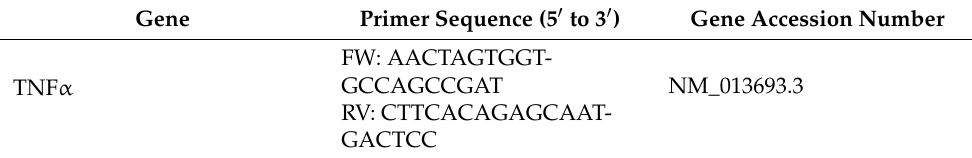
Table 2. Cont. Gene Primer Sequence (5 (cid:48) to 3 (cid:48)